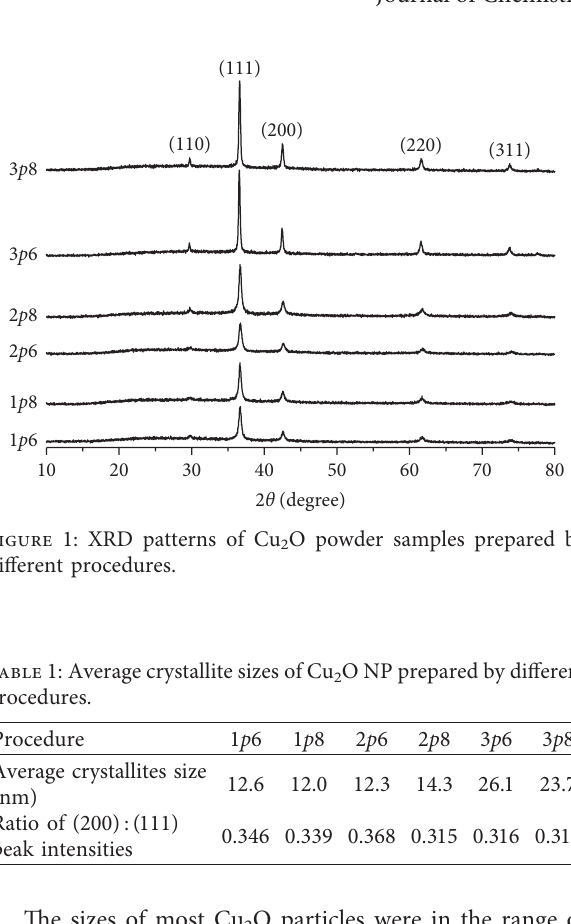
2 O NP prepared by different